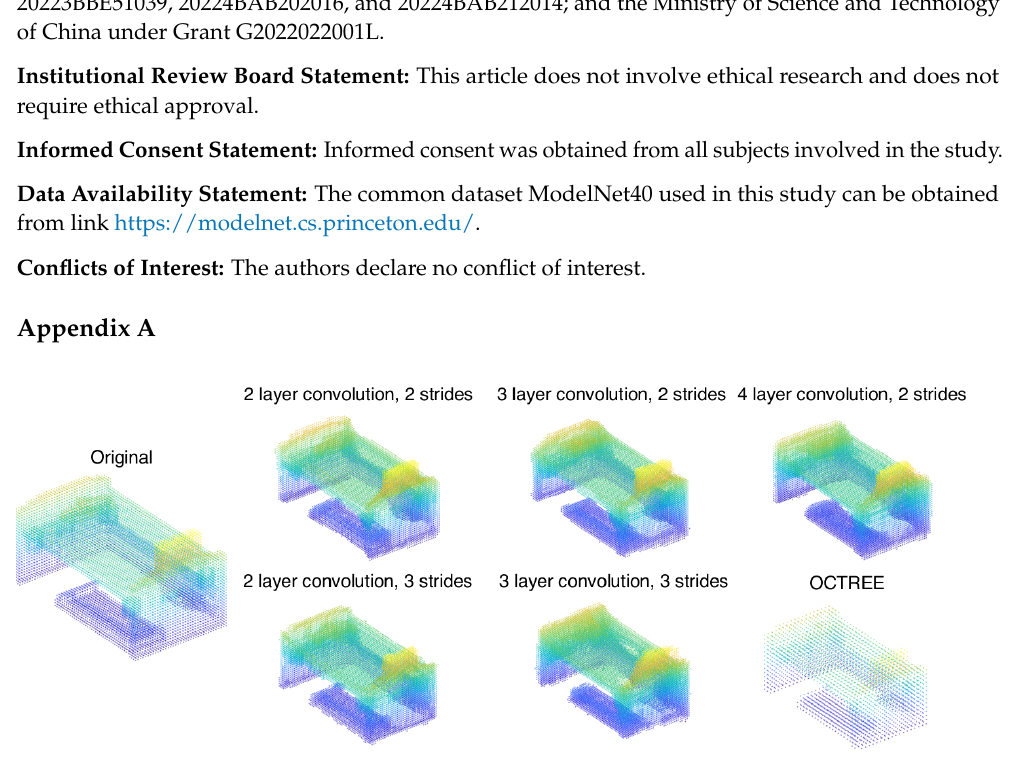
Figure A1. The compression performance of the scheme configured with different depths and